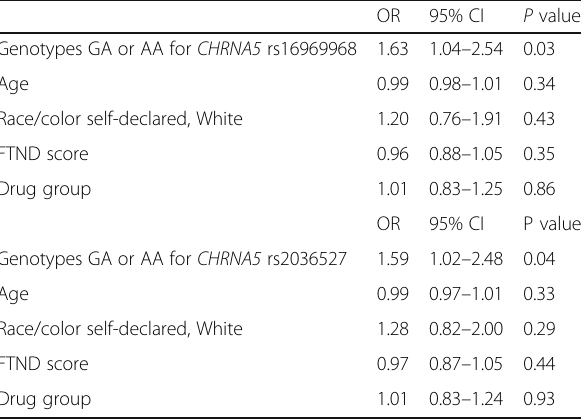
Table 2 Success rate in smoking cessation for patients according to genotypes CHRNA2 rs2472553 Patient groups